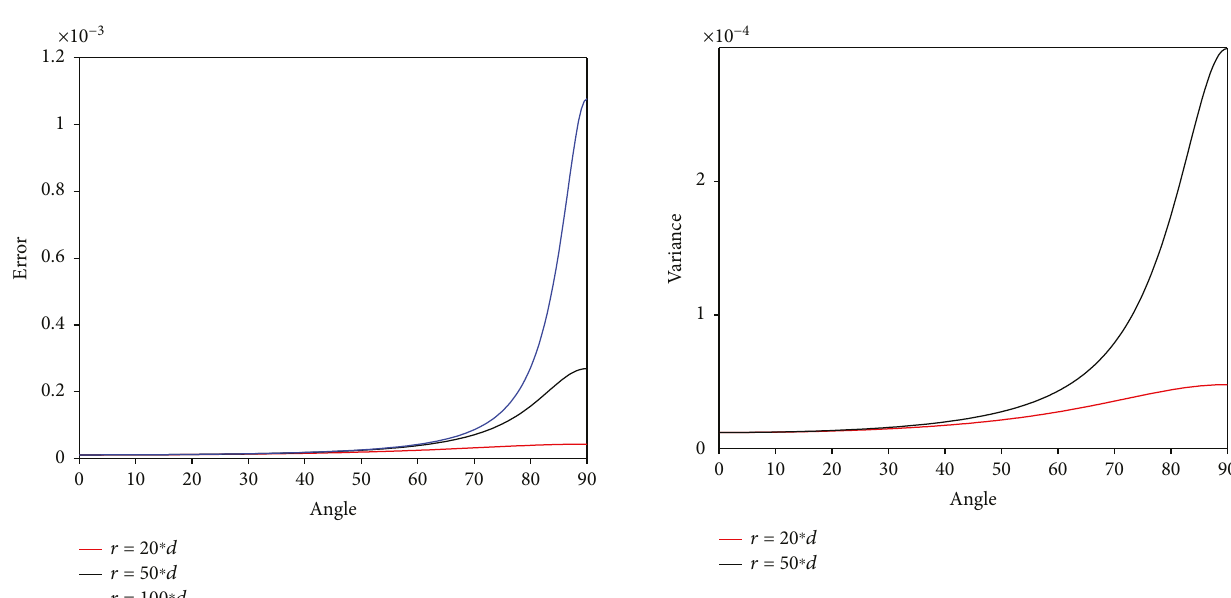
Figure 6: Asymptotic variance with respect to the change of θ and r .